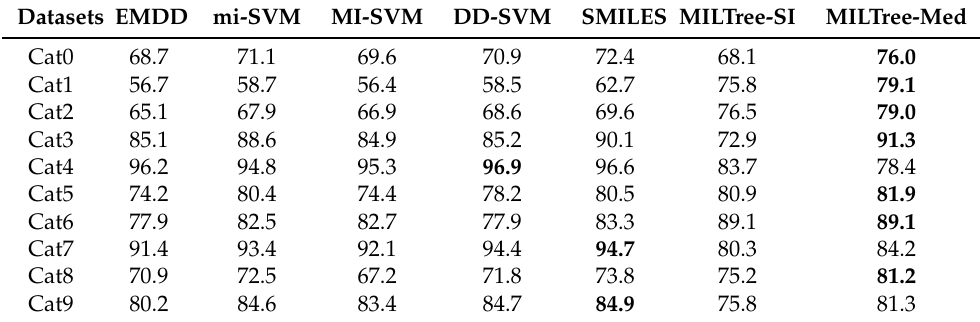
Table 7. Comparison between MILTree-SI/MILTree-Med and related methods from the literature on the Corel Dataset.